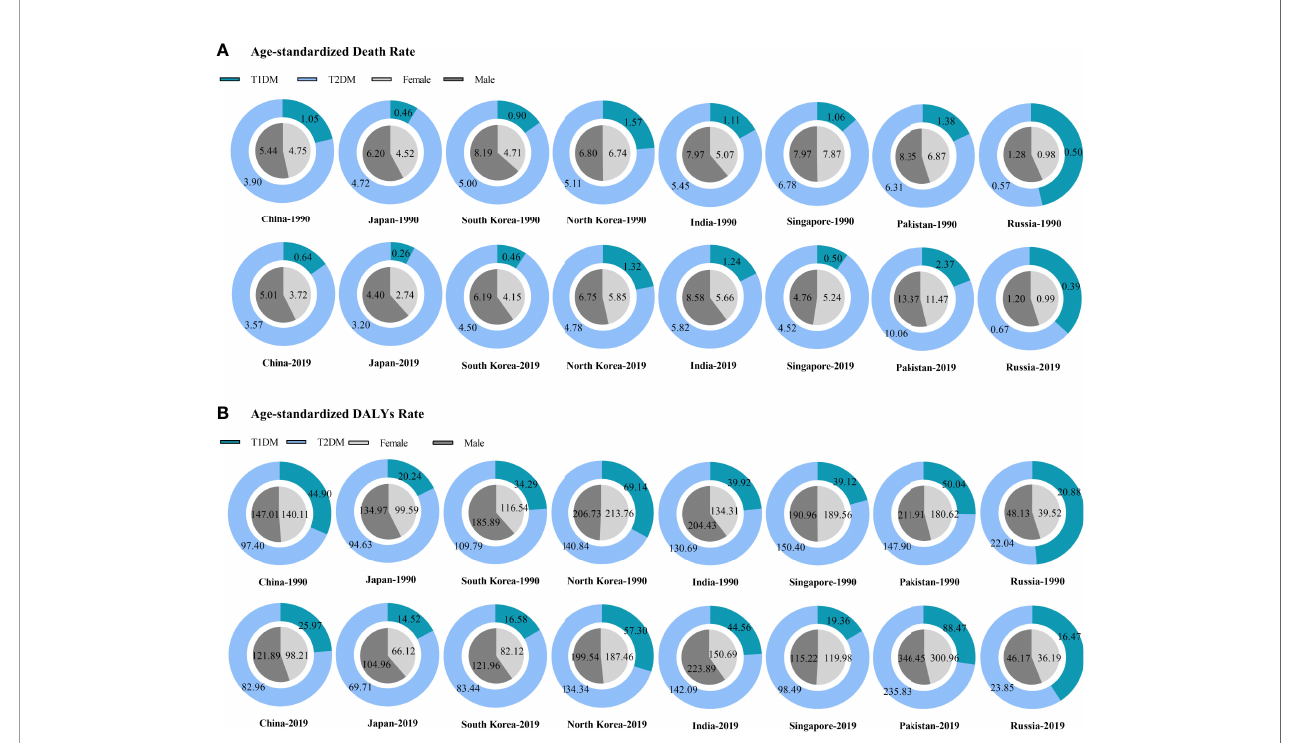
FIGURE 3 | The burden of diabetes-related CKD in China and neighboring countries. (A) Age-standardized death rate; (B) Age-standardized DALYs rate. CKD, chronic kidney disease; T1DM, type 1 diabetes mellitus; T2DM, type 2 diabetes mellitus; DALYs, disability-adjusted